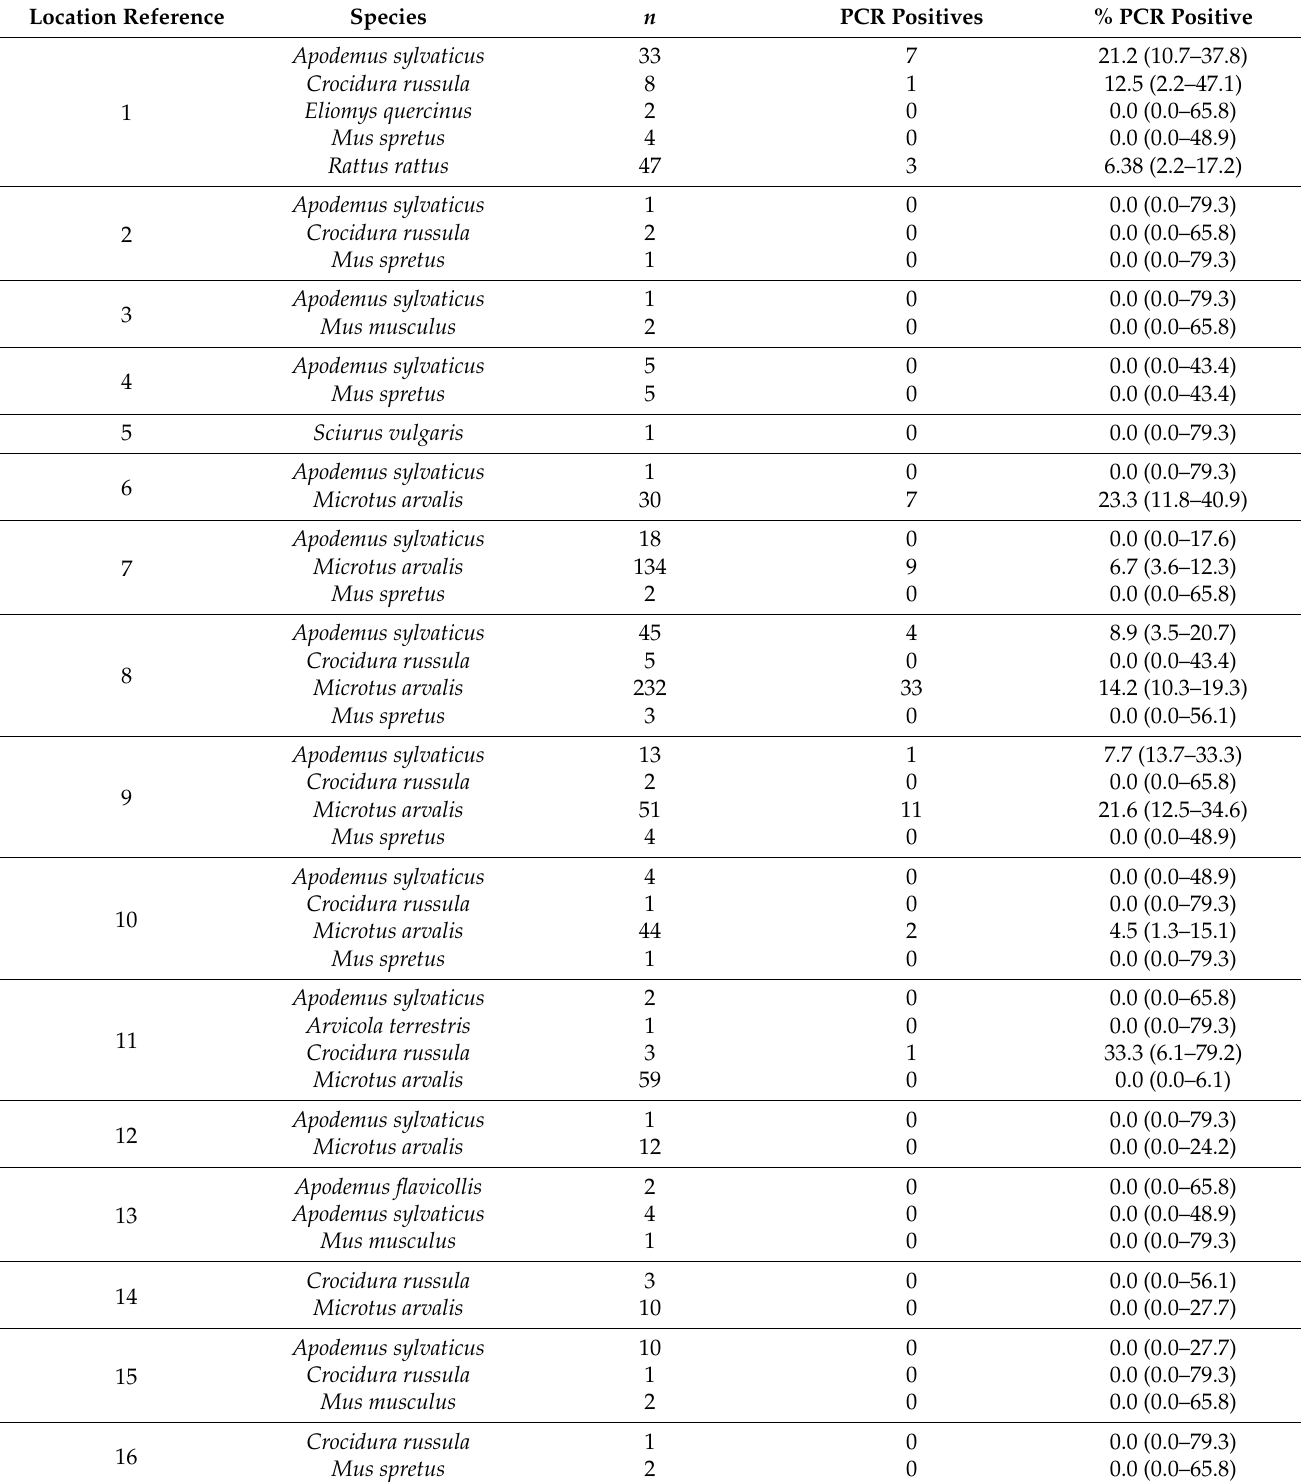
Table 2. qPCR results by micromammal species object of survey in this study for each location. Species are displayed along with sample size ( n ) and the number of qPCR positive samples (PCR positives). In addition, 95% exact confidence intervals are shown within